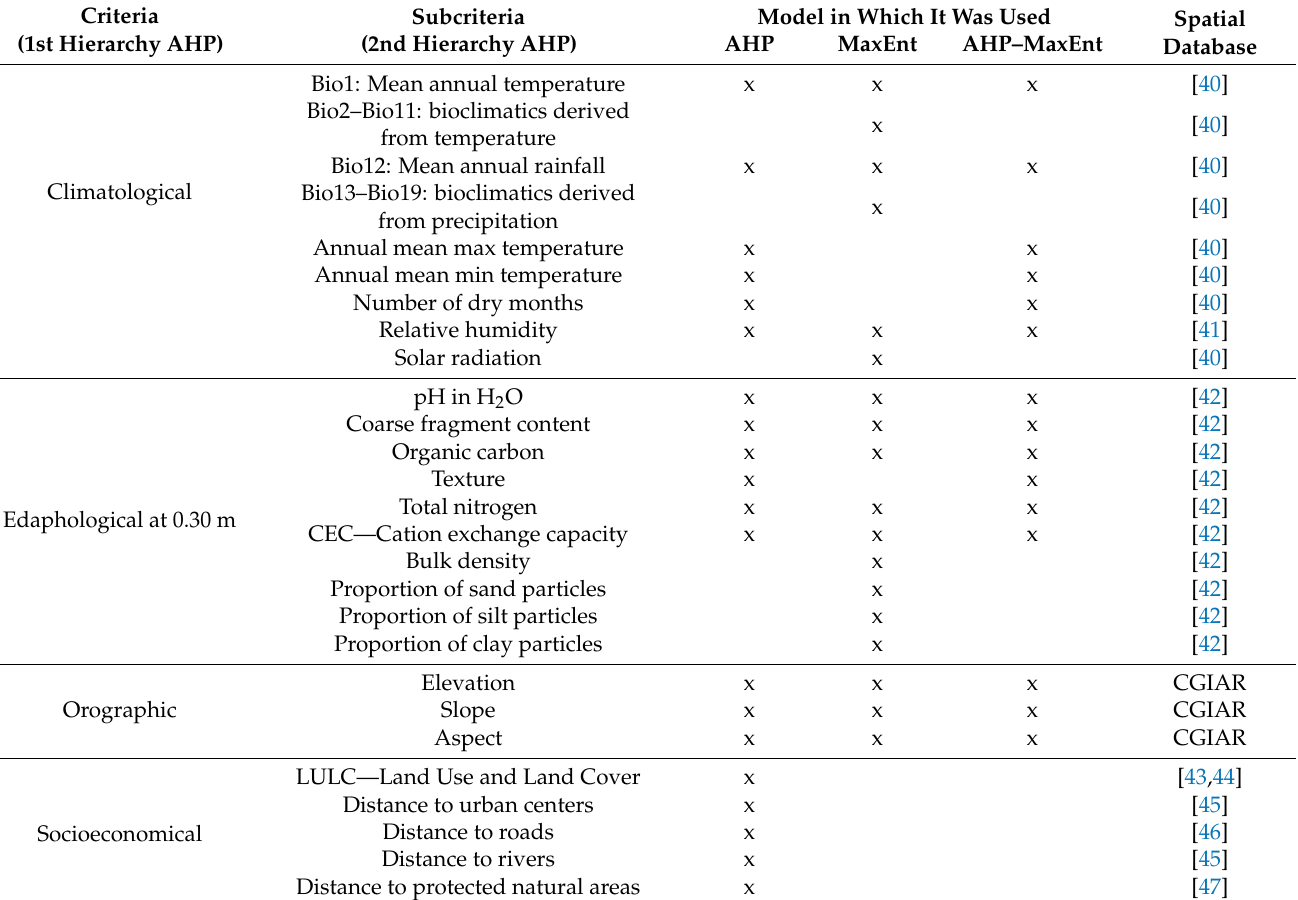
Table 1. Criteria used for each modeling